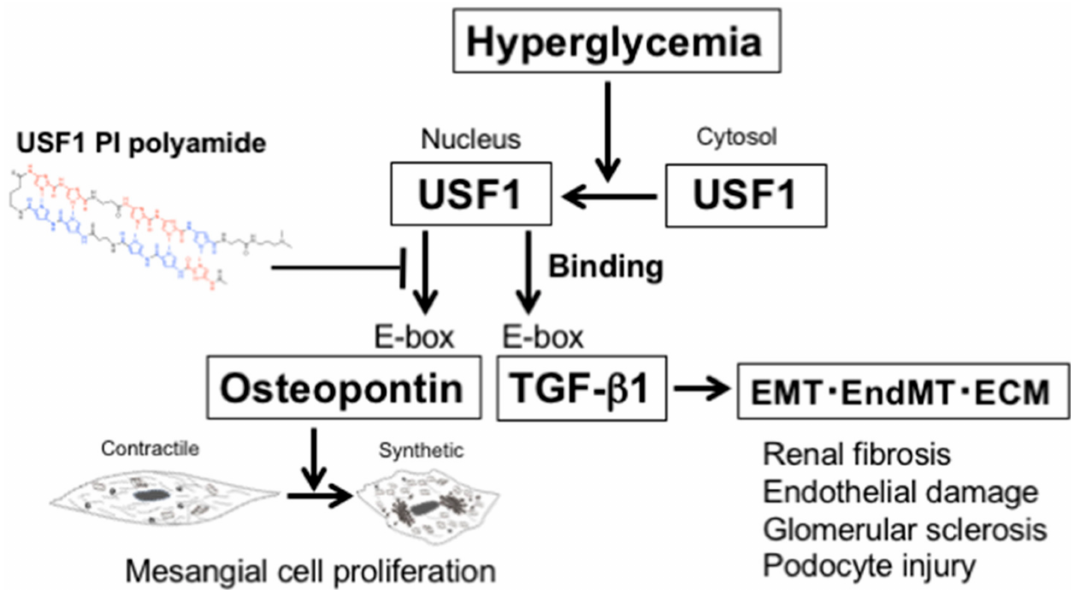
Figure 10. Diagram of the involvement of upstream stimulatory factor 1 (USF1) in the pathogenesis of diabetic nephropathy and the transcriptional inhibition of transforming growth factor (TGF)- β 1 and osteopontin promoters by pyrrole-imidazole (PI) polyamide to prevent the binding of USF1 (USF1 PI polyamide). EMT: epithelial–mesenchymal transition, EndMT: endothelial–mesenchymal transition, ECM: extracellular